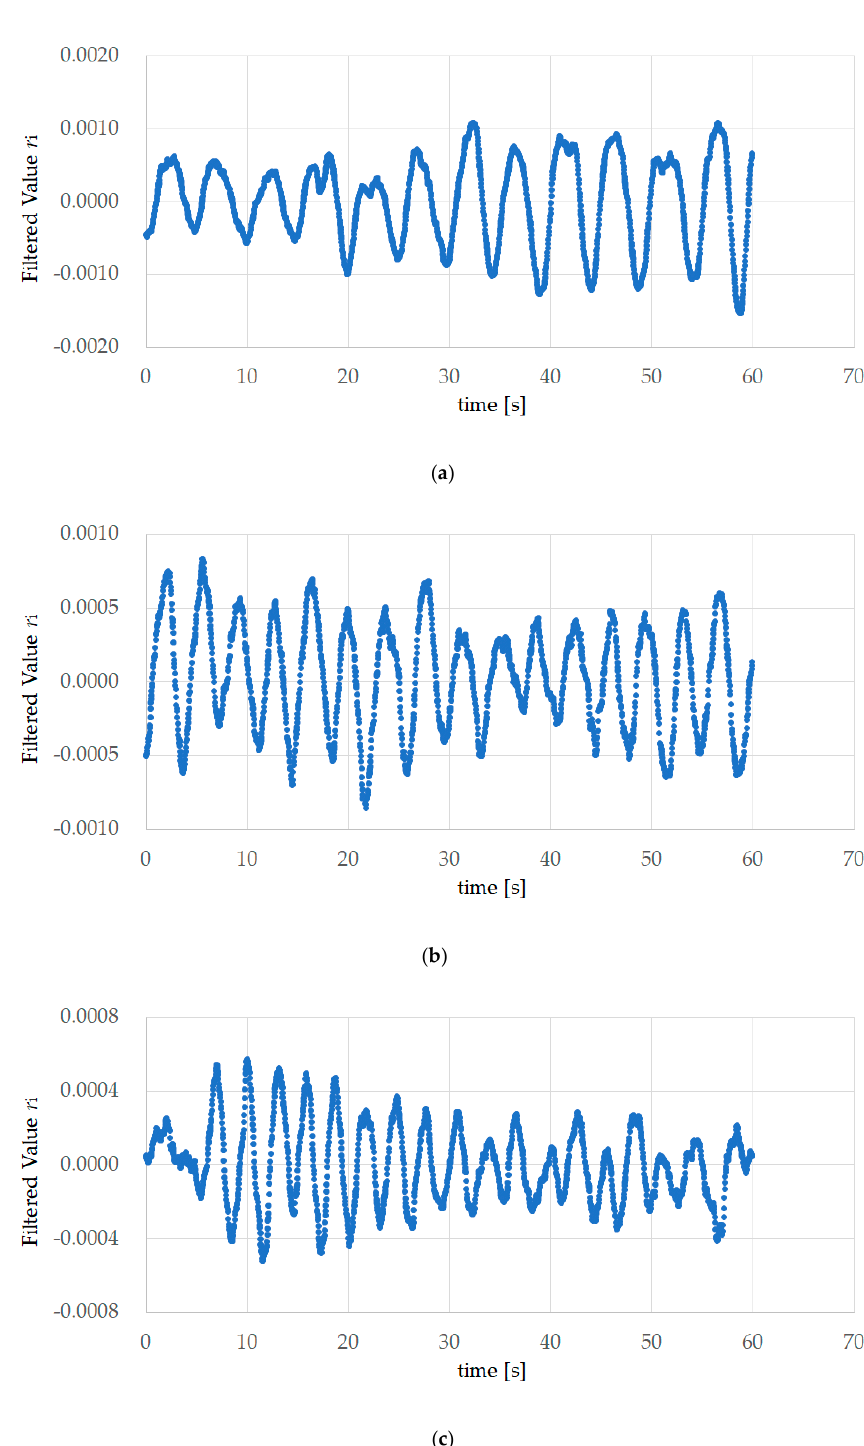
Figure 5. FFT processing data obtained from experiment results of EX200mHz12rpm, EX267mHz16rpm, and EX333mHz20rpm for subject A. Median filter processing, band-pass filter processing